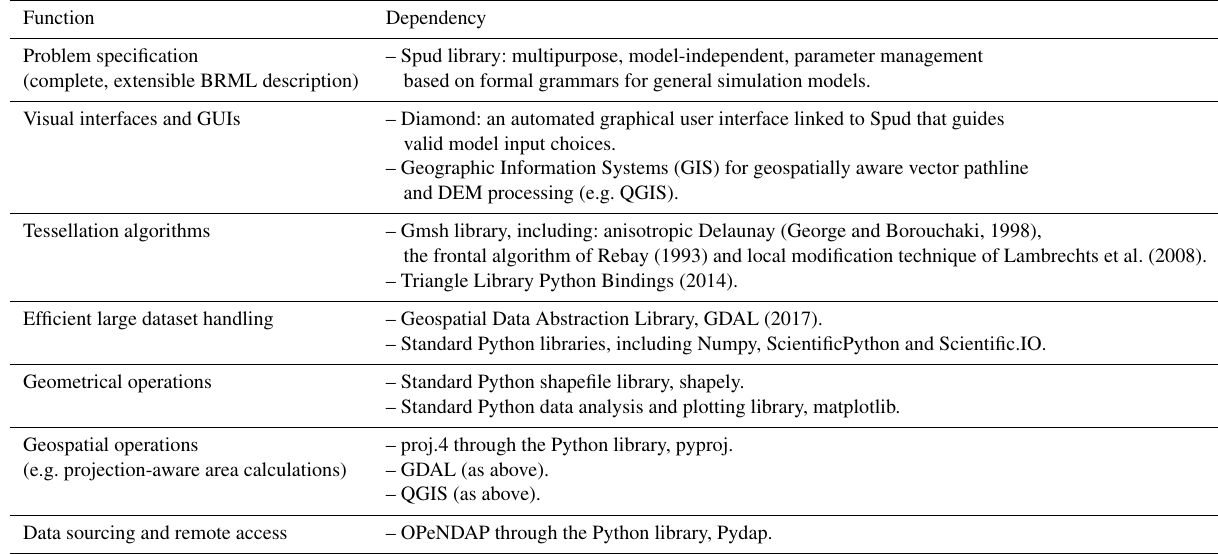
Table 2. Function of external dependencies and libraries applied in the approach.